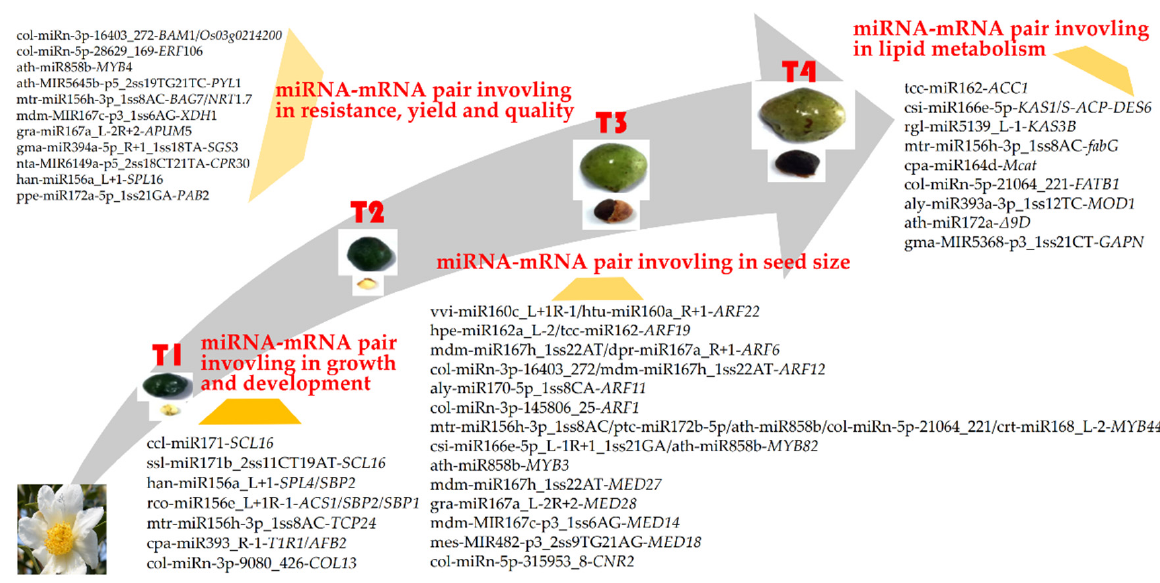
Figure 14. miRNA–mRNA regulatory modules in developing seeds of tea oil camellia.